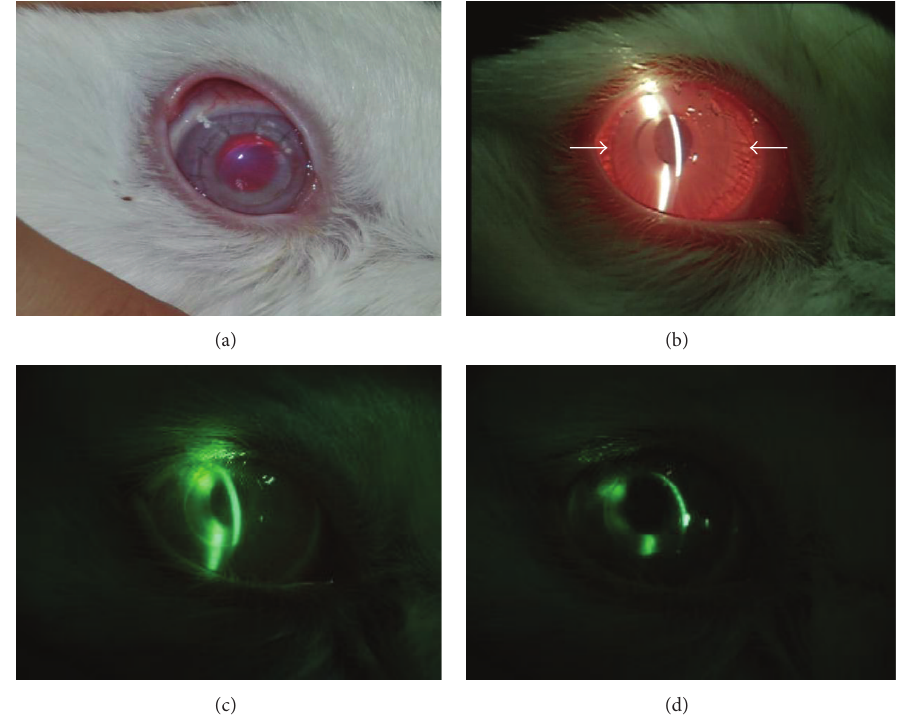
Figure 2: Five sutures were proceeded on the entrance of pocket with 10-0 silk and node buried inside; arrow indicated the transparency implant (a). Slit-lamp examination. Arrows indicate a successful inlay implant, which is almost imperceptible because of its extreme thinness after one week (b). Representative slit-lamp micrographs of the rabbit corneas. Cornea with Biocornea at 3 months (c). Cornea with Biocornea at 6 months